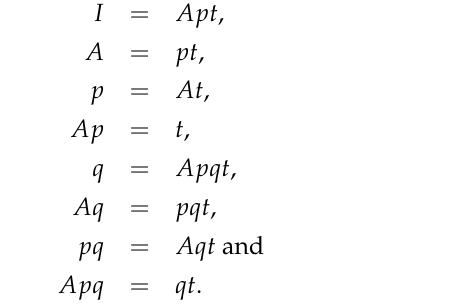
FFSP design displayed in the third